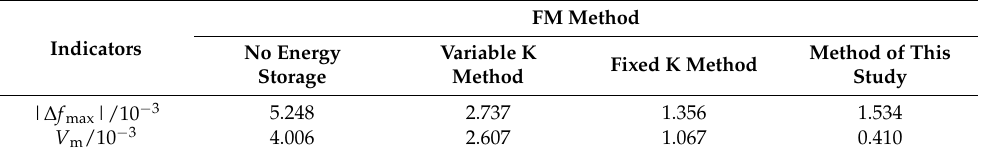
Table 1. Case 1: indicator statistics of frequency regulation.